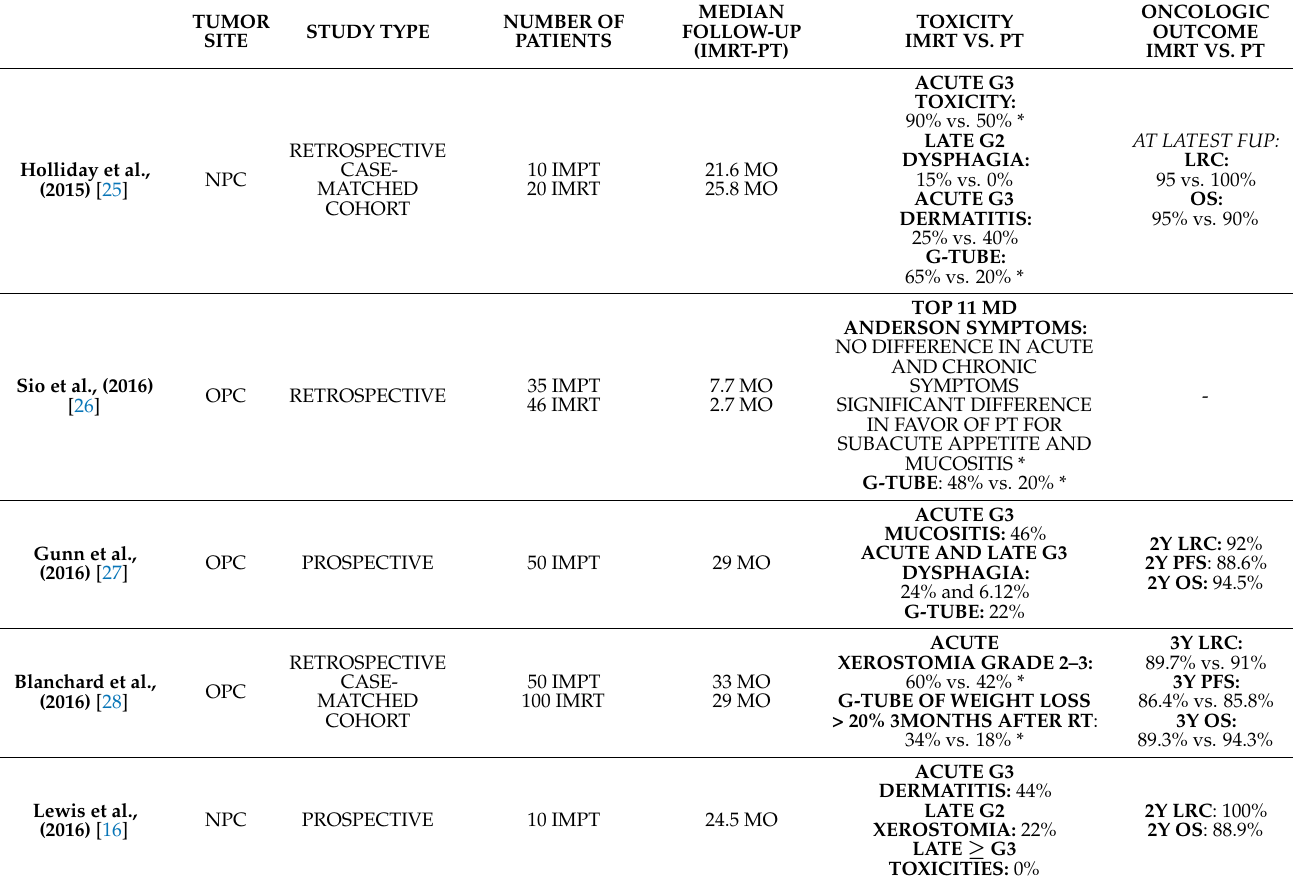
Table 1. Study characteristics, toxicity, and oncologic outcomes of all series reporting experience with single-modality PT for HNSCC, ordered by year published. Studies investigating other heavy ion particles e.g., carbon, non-SCC etiologies, and multiple HNC locations were